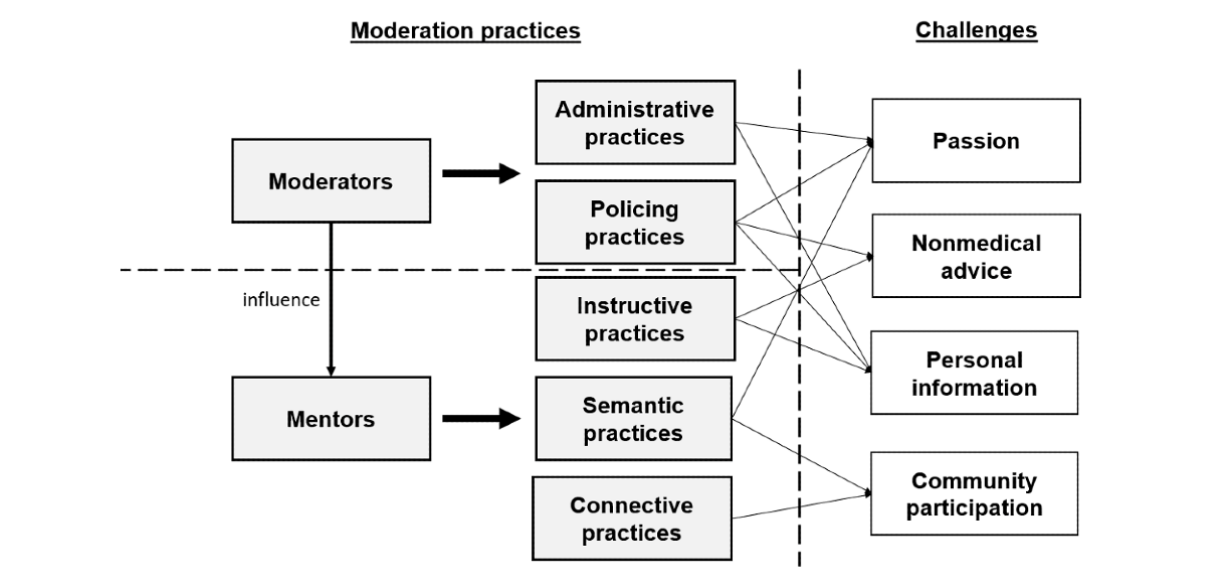
Figure 2. Graphical summary of our